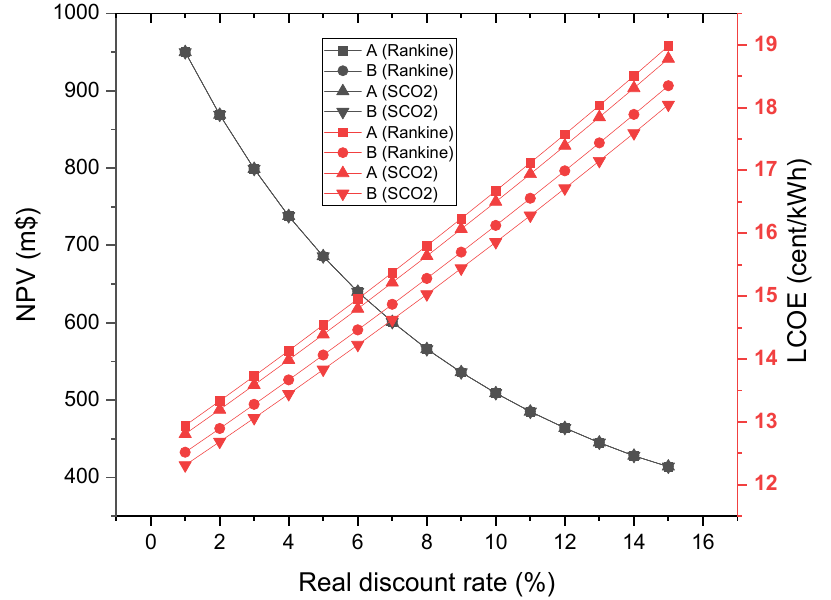
Figure 10. Effect of real discount rate on NPV (in million dollars) and LCOE of the various scenar- ios.